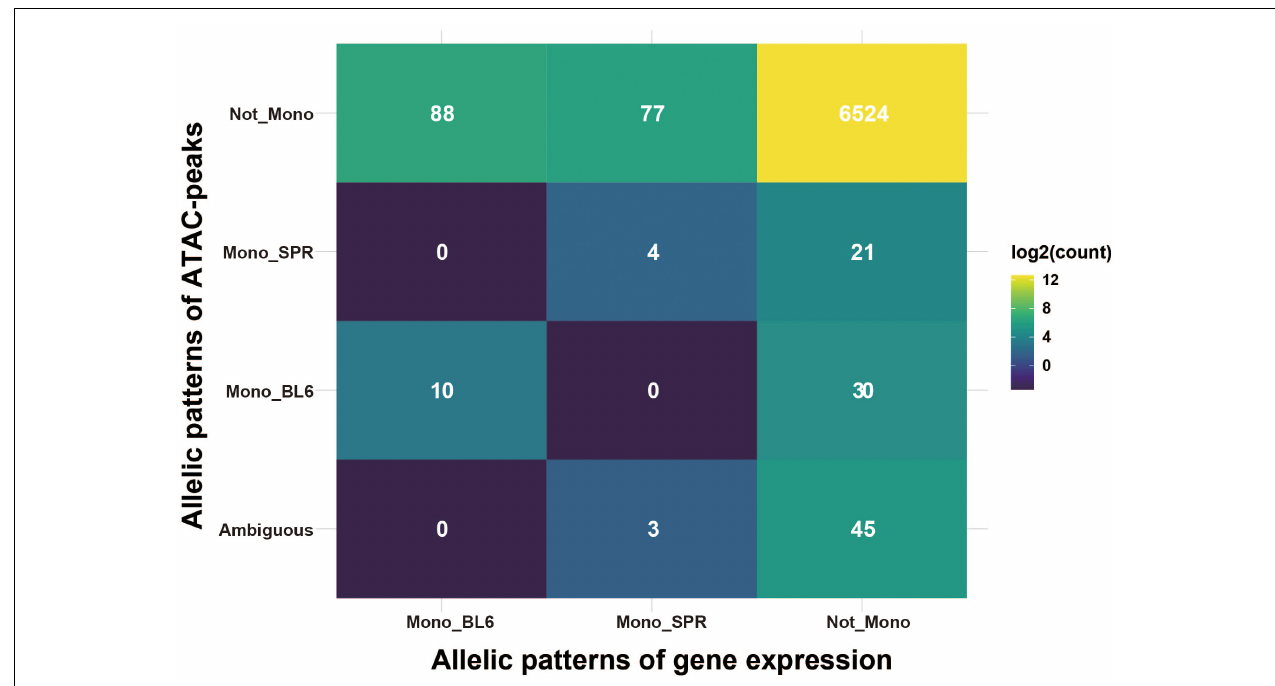
FIGURE 4 | Integrated patterns of allelic gene expression and ATAC-peaks. The heatmap presents the integrated allelic patterns of gene expression and ATAC-peaks in its promoter regions (2.5 kb upstream and 0.5 kb downstream of TSS). Gene expression was classified into three classes: (1) Mono_BL6, means genes monoallelically expressed in C57BL/6J allele; (2) Mono_SPR, means genes monoallelically expressed in SPRETUS allele; (3) Not_Mono, means the genes are not monoallelic genes. ATAC-peaks are classified similarly with one more class indicated as “ambiguous” which means there are both “Mono_BL6” peaks and “Mono_SPR” peaks in that gene. Numbers in each cell indicate the count of overlapped genes. The color filled in cells are scaled by log2 of count.